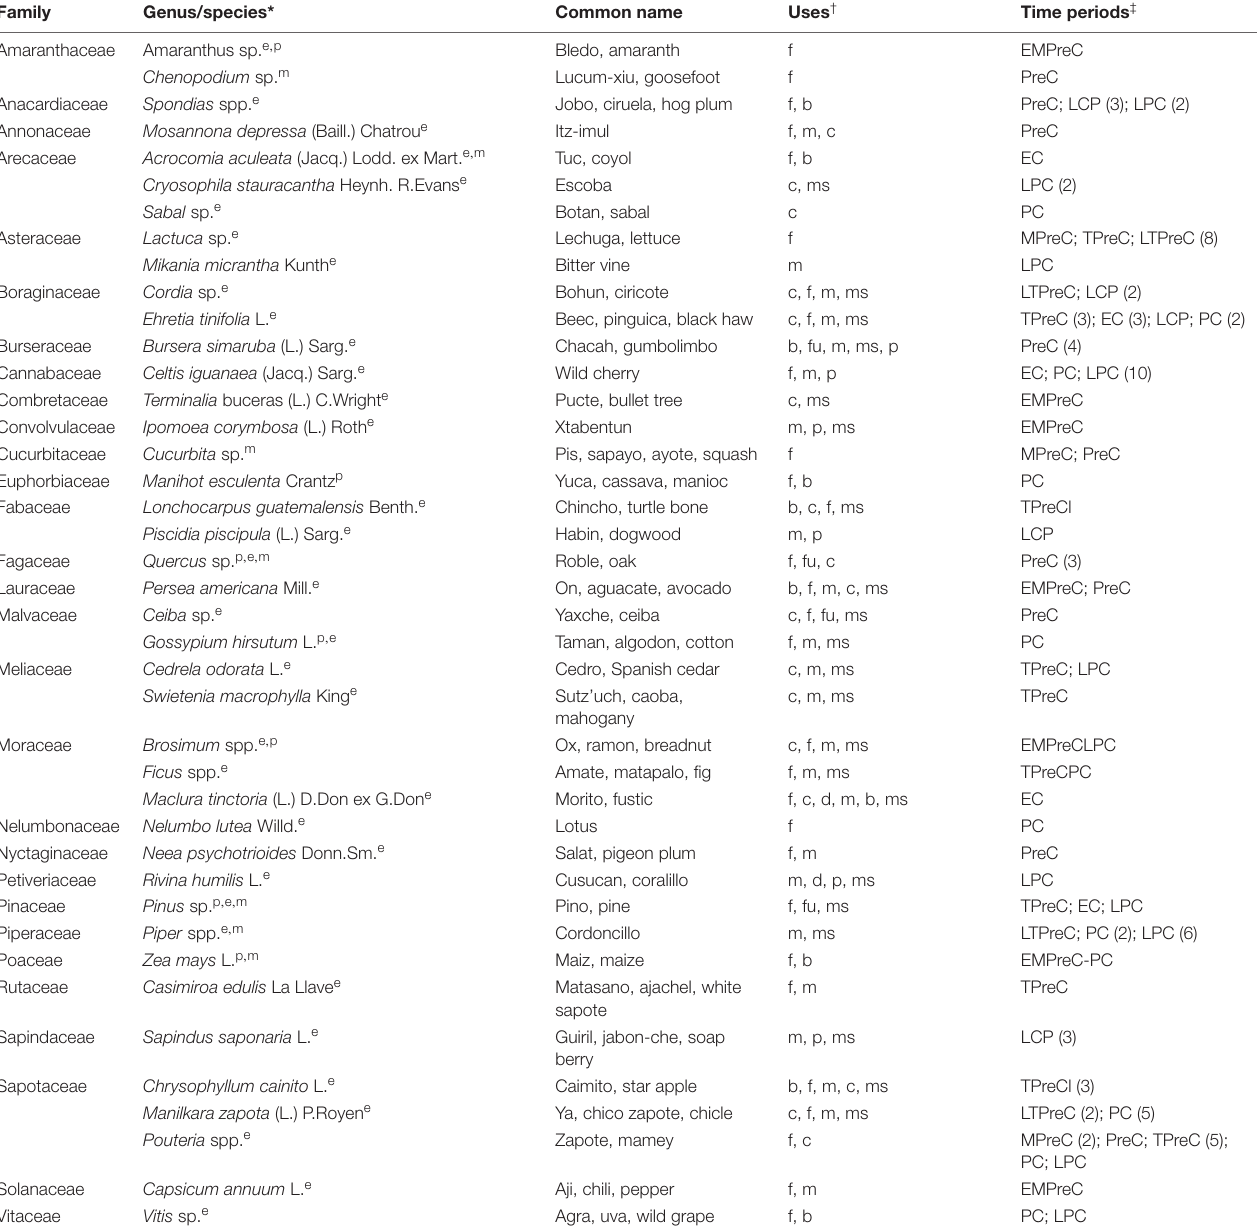
TABLE 2 | Yaxnohcah economic plants by family and time